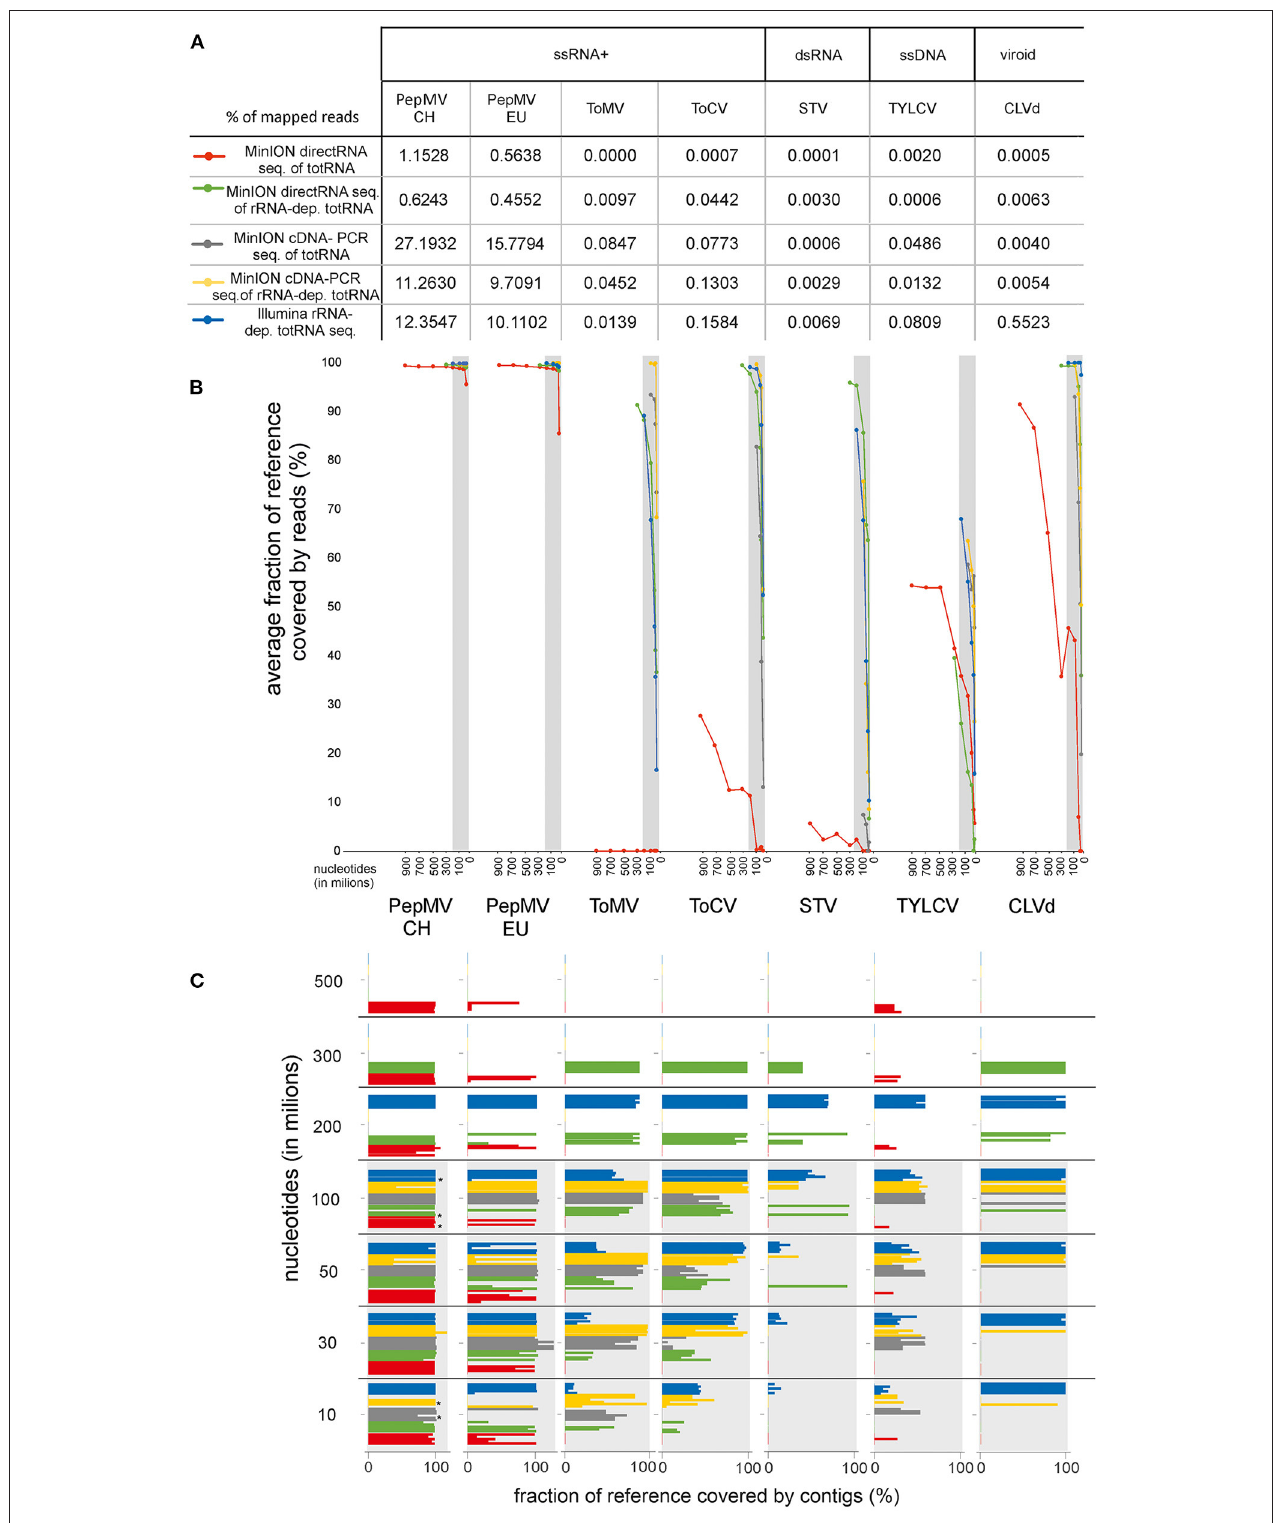
FIGURE 4 | Comparison of MinION sequencing: direct RNA sequencing of totRNA, direct RNA sequencing of rRNA-depleted totRNA, cDNA-PCR sequencing of totRNA, cDNA-PCR sequencing of rRNA-depleted totRNA and Illumina sequencing of rRNA-depleted totRNA using data size-normalized subsamples. Results